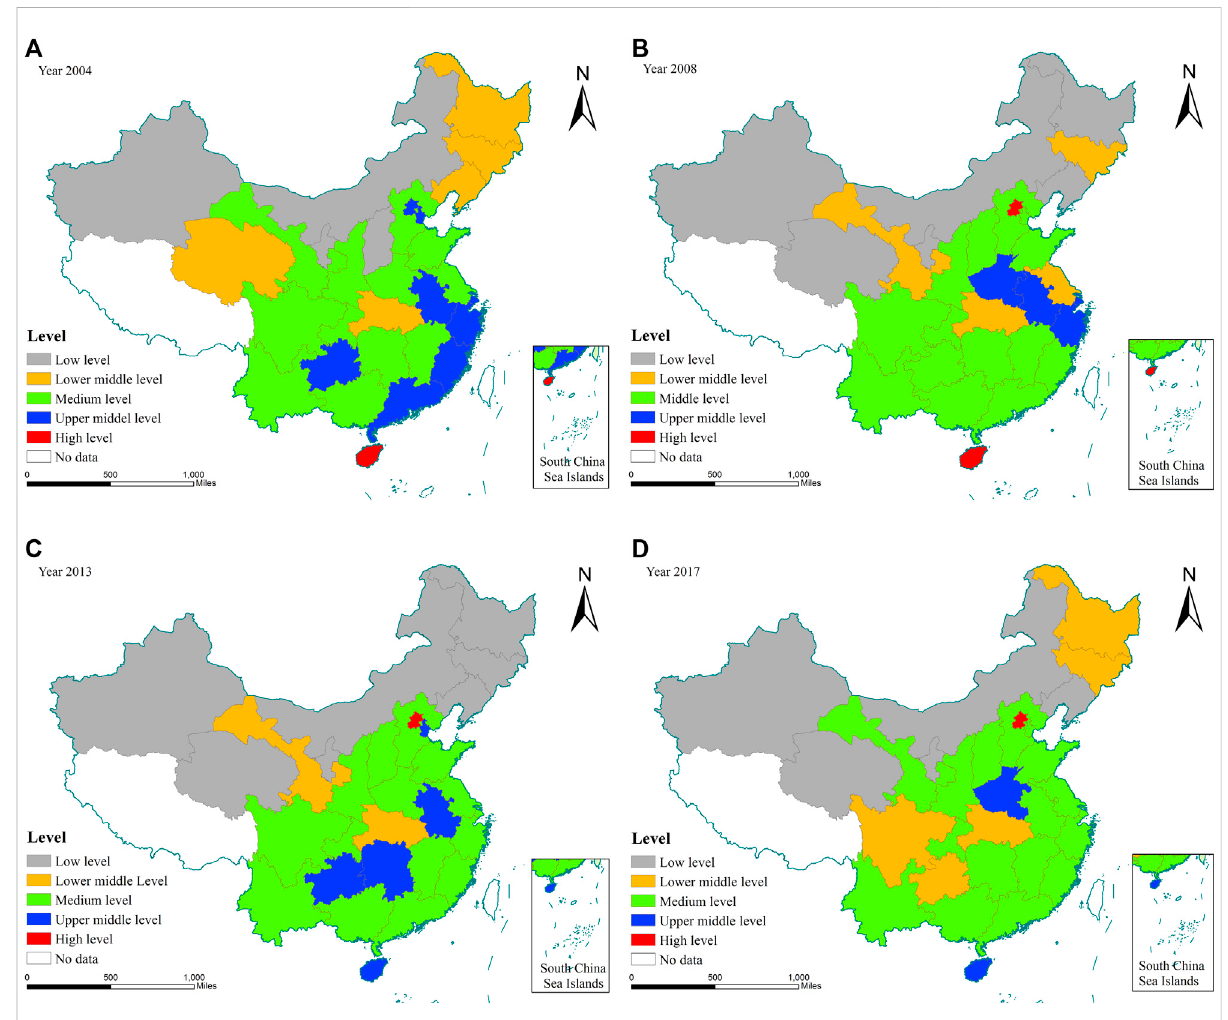
FIGURE 4 Spatial differences in China ’ s Ecological well-being performance levels from 2004 to